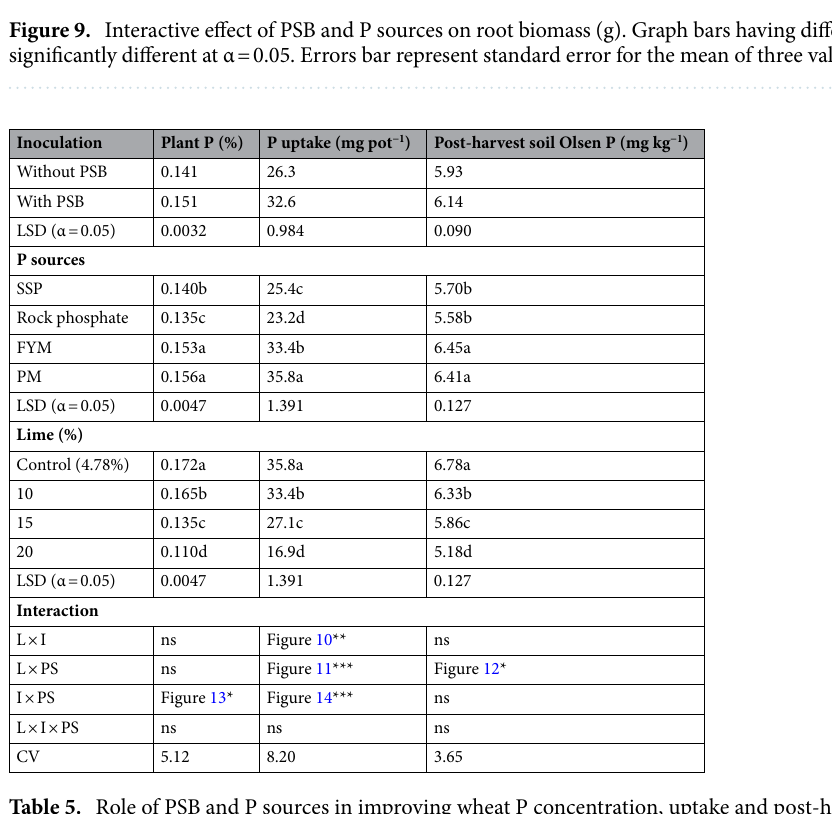
Table 5. Role of PSB and P sources in improving wheat P concentration, uptake and post-harvest Olsen P content in soil under varying lime levels. PSB, LSD, SSP, FYM, PM and ns denote phosphate solubilizing bacteria, least significant difference, single super phosphate, farmyard manure, poultry manure and non- significant interaction, respectively. Means with different letter in each column are significantly different at p ≤ 0.05. Single asterisk stands for significant, Double asterisk stands for higly significant, Triple asterisk stands for very higly significant.